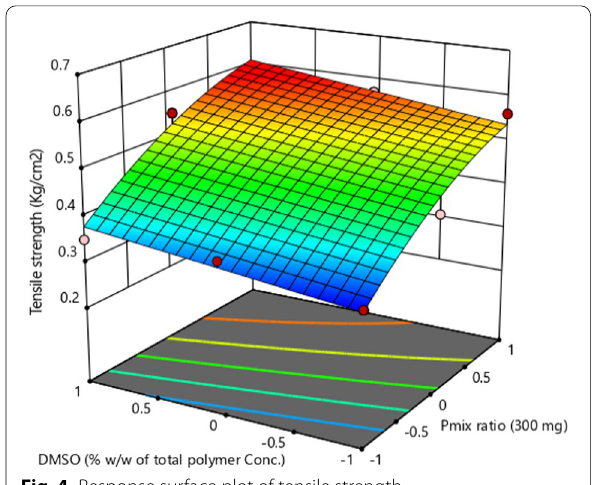
Table 5 Water vapor transmission rate of transdermal patch (F1–F9) Batch code Initial wt. (g) Wt. after 6 h Wt. after